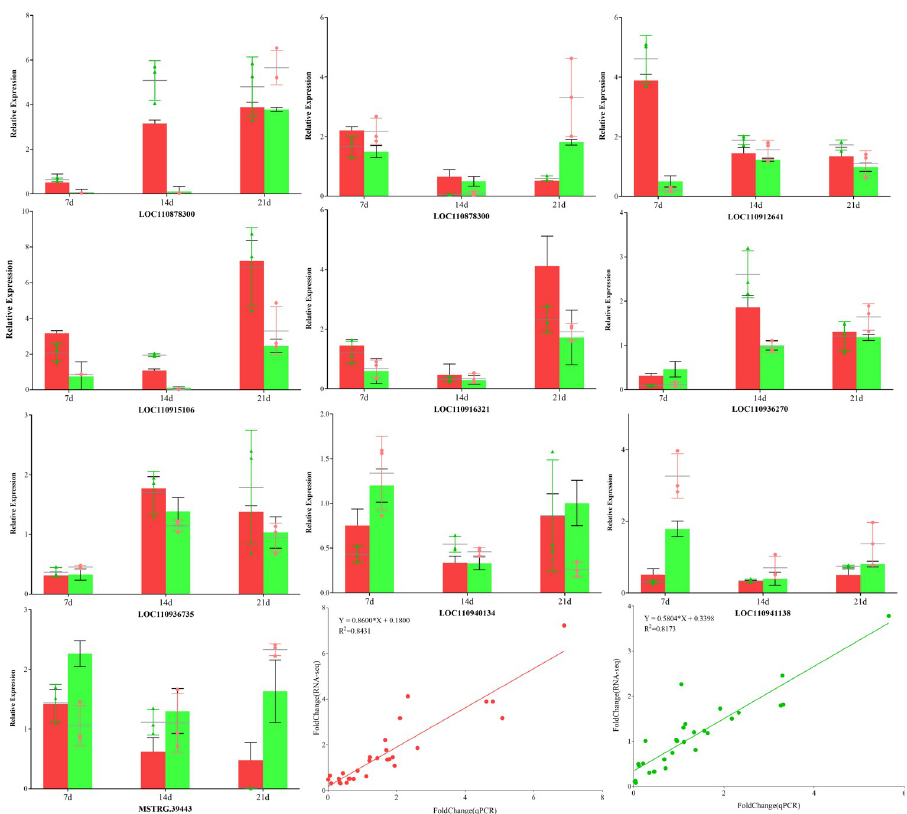
Fig 12. RT-qPCR analysis of 10 drought-stress related DEGs during various stages of drough stress. Bars with standard errors represent relative expression level determined by the ratio of sample average FPKM to control. The scatter plot on the bar graph represents the corresponding relative expression level determined from three independent biological replicates by RT-qPCR using the 2 - 44 Ct method. Correlation between RT-qPCR and RNA-seq for select DEGs is also shown in the